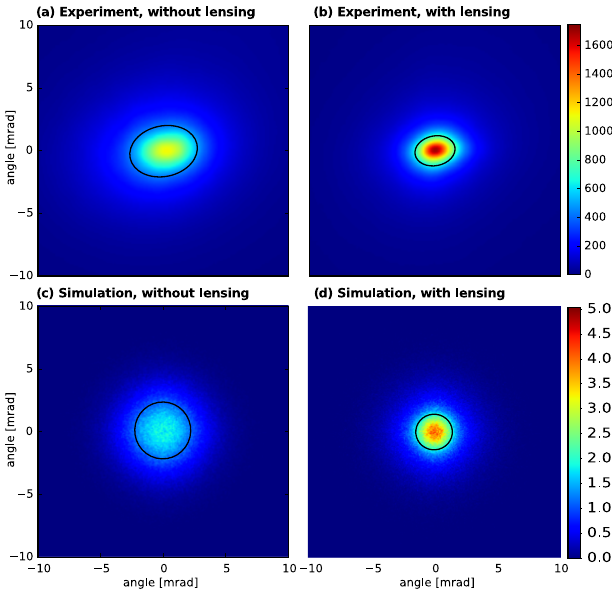
FIG. 2. Beam profiles as seen on the scintillation screen: Inset (a) shows the averaged and center aligned beam profile of 227 reference shots with the acceleration stage only. Inset (b) shows the averaged and center aligned beam profile of 175 shots with the focusing stage using an electron density of 1 . 6 × 10 19 cm − 3 ¼ 8 . 75 mm. In both pictures the black and a separation of L g ellipse encloses the standard deviation of a 2D gaussian fit function to the beam profile. The black ellipse reduces its area from 16 μ sr (left) to 6 μ sr (right) as the focusing stage is turned on. (c) and (d) show the corresponding data from the EPOCH 3 D Simulation: The bunch ’ s initial divergence is set up to match the experimentally measured divergence of 16 μ sr (c). The encircled solid angle reduces to 7 . 3 μ sr after propagation through 2.5 mm ¼ 1 × 10 19 = cm 3 with 0.5 mm linear plasma with a density of n p ramps on both